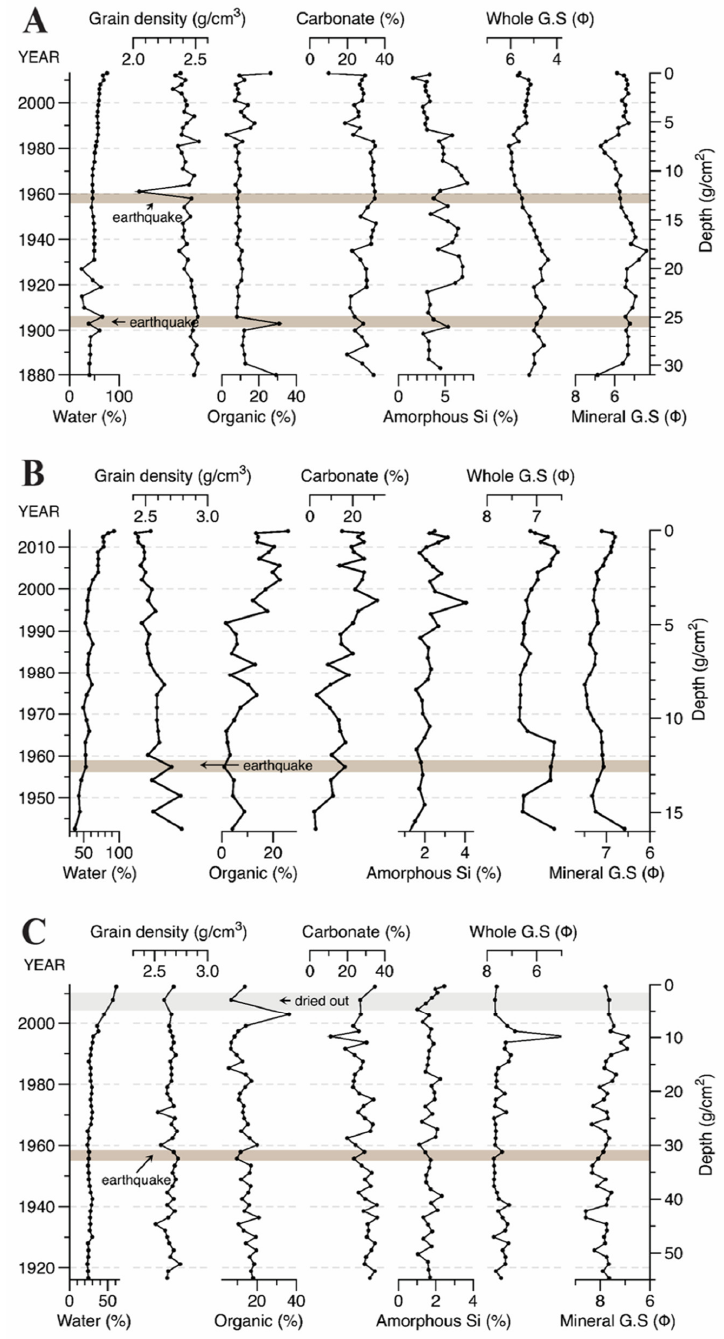
Figure 6. Sediment characteristics of ( A ) Olgoy, ( B ) Boontsagaan, and ( C ) Orog lakes (water content % (water), grain density g/cm 3 , organic matter % (organic), carbonate %, amorphous silica %, whole grain size ϕ (whole G.S), and mineral grain size ϕ (mineral G.S)). Earthquake events are indicated in brown. The dried event is indicated in